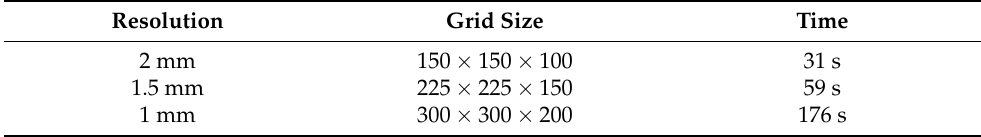
Table 1. Average running time for each antenna.